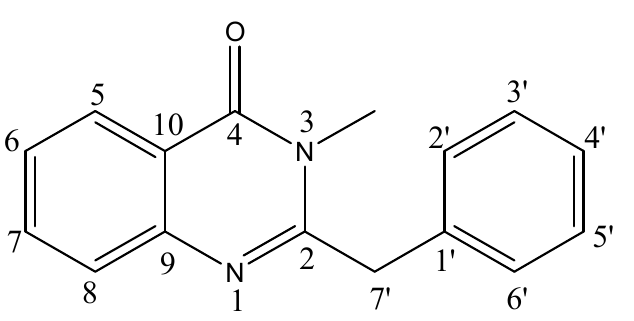
Figure 1. Structure of compound 1